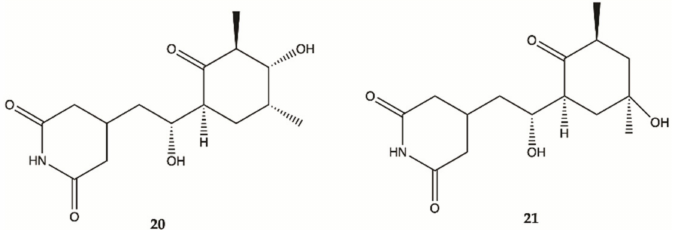
Figure 9. Streptoglutarimides 20 and 21 isolated from Actinomycete Derivates Streptomyces sp. ZZ741